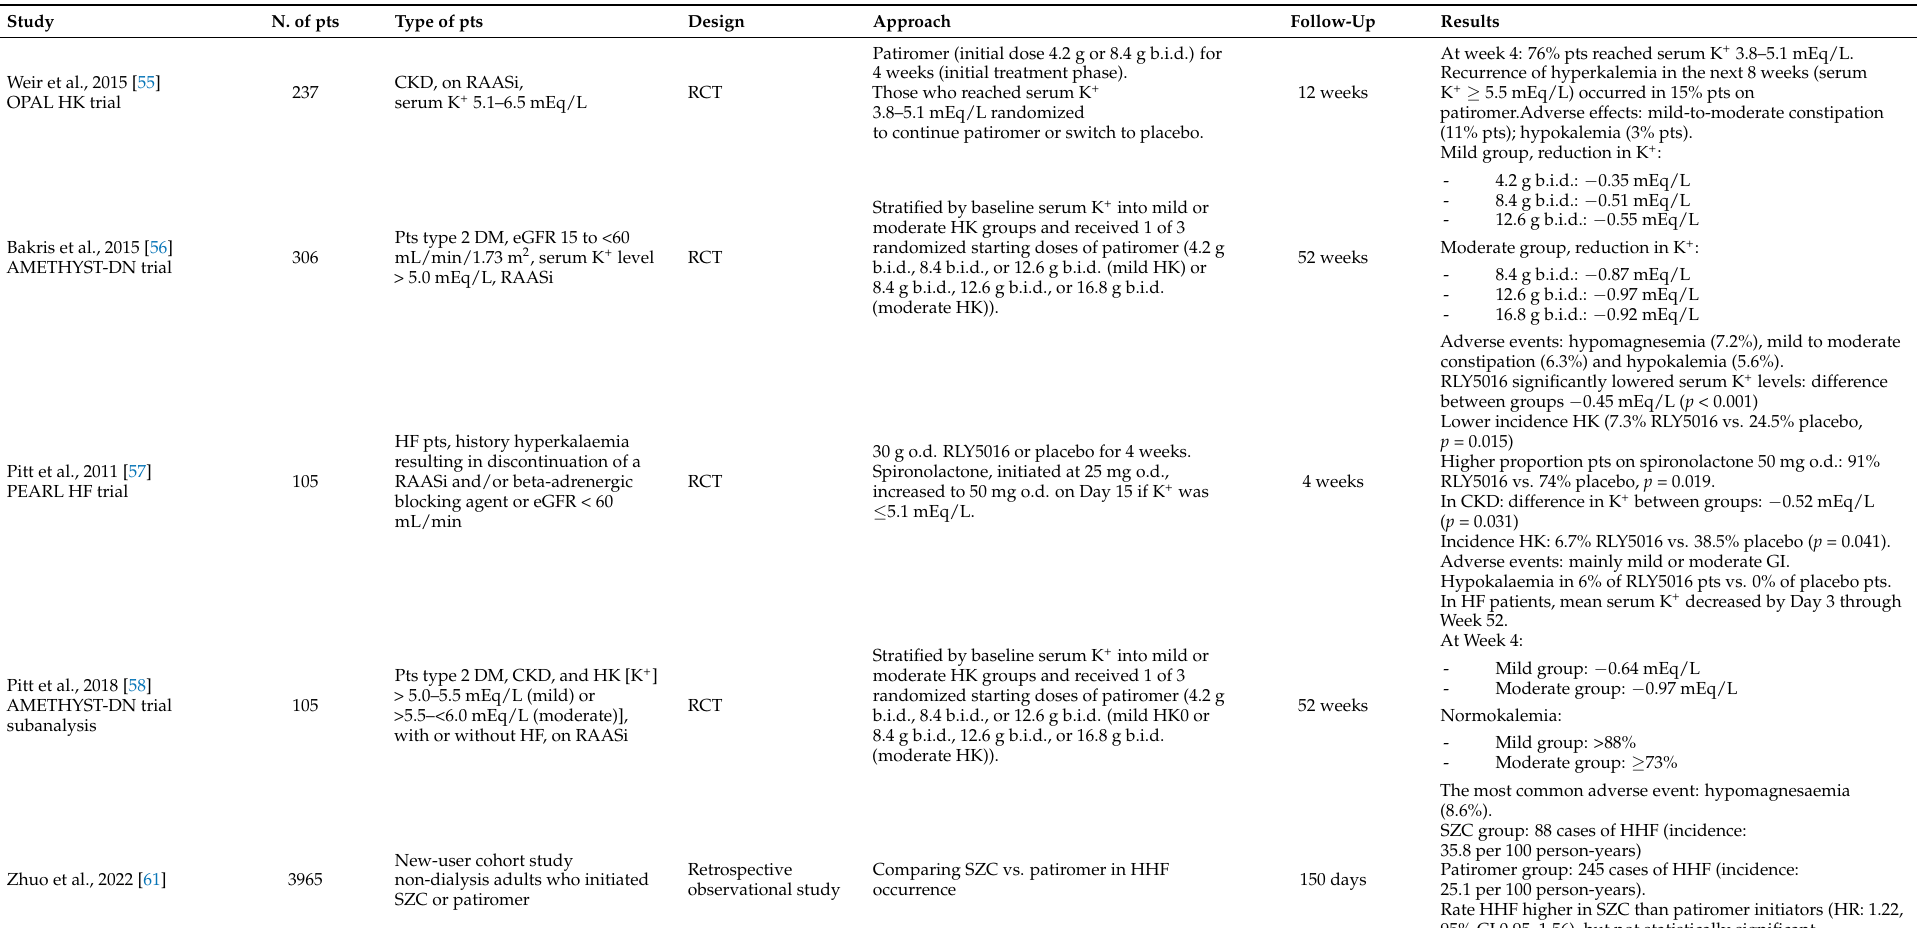
Table 4. Main characteristics of studies on